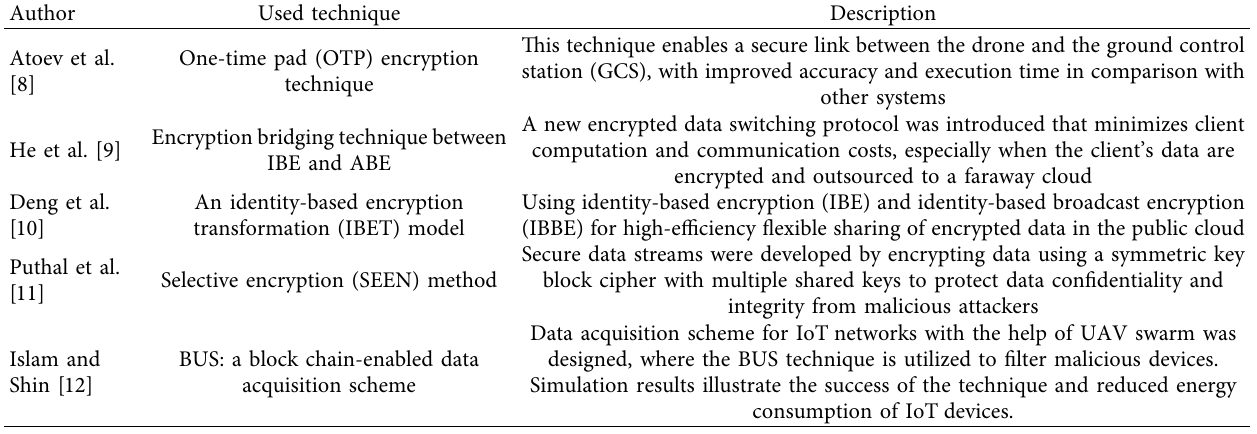
Table 1: Security techniques for